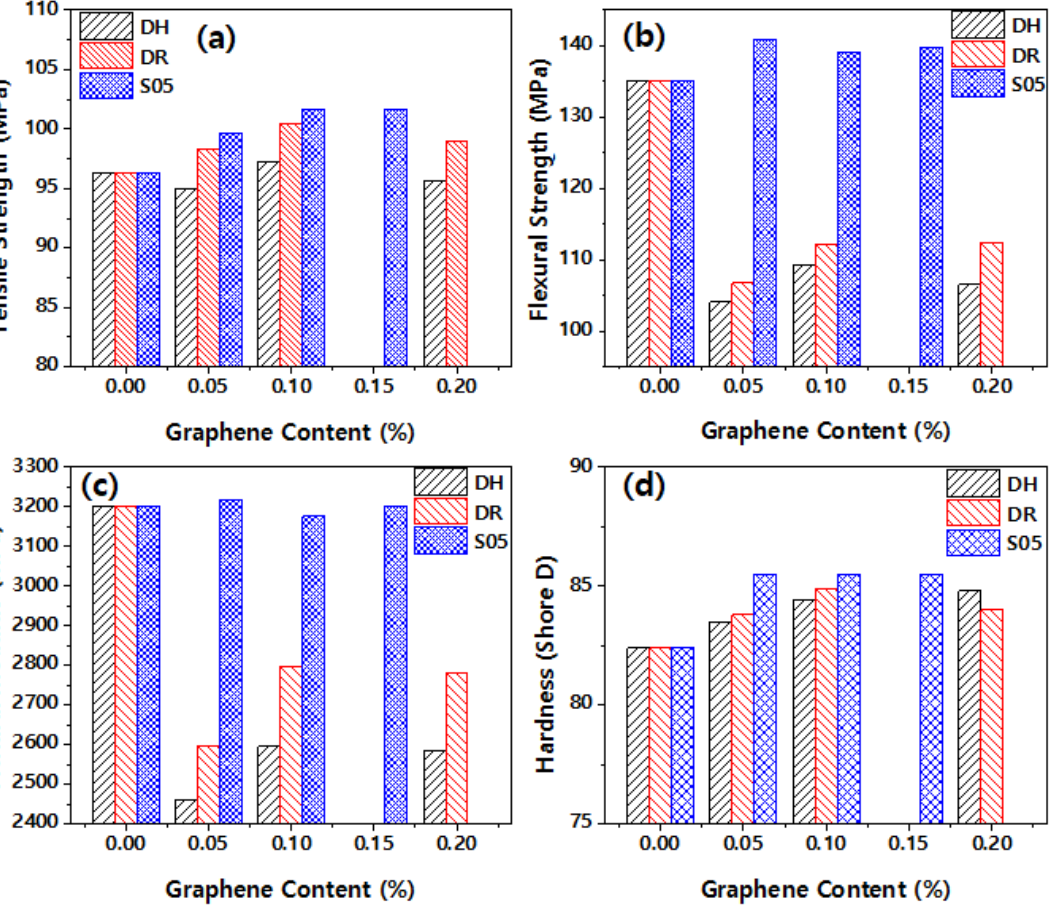
Figure 8. Mechanical properties of the different content of graphene: ( a ) Tensile strength, ( b ) flexural strength, ( c ) flexural modulus, and ( d ) hardness.